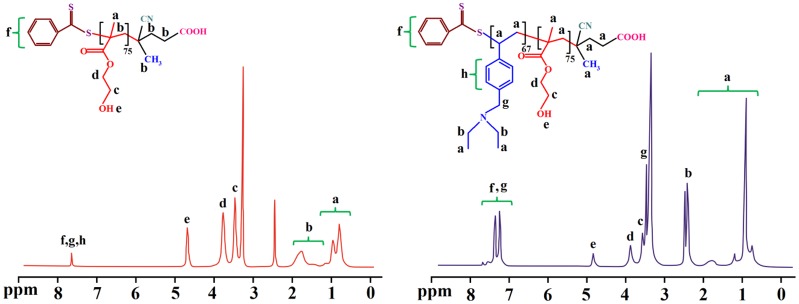
The 1H NMR spectra of the PHEMA and PHEMA-b-PVEA (DMSO-d
6, 25 °C).